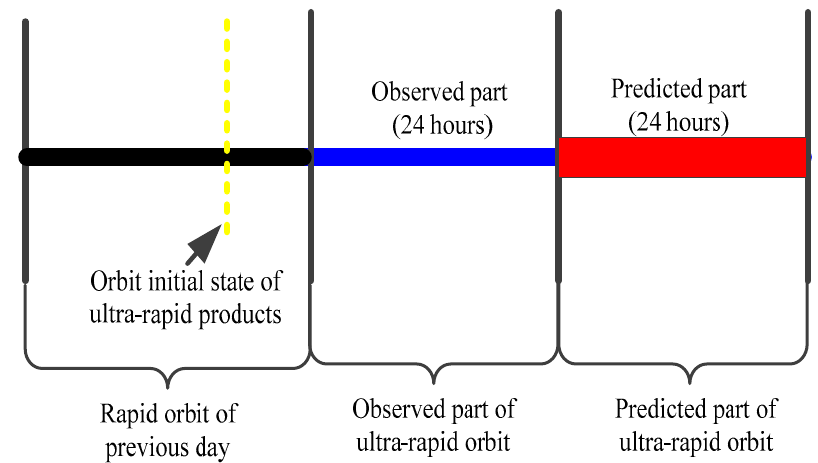
Figure 3. Merger of the two-day observed orbit for the estimation of the orbit’s initial states.